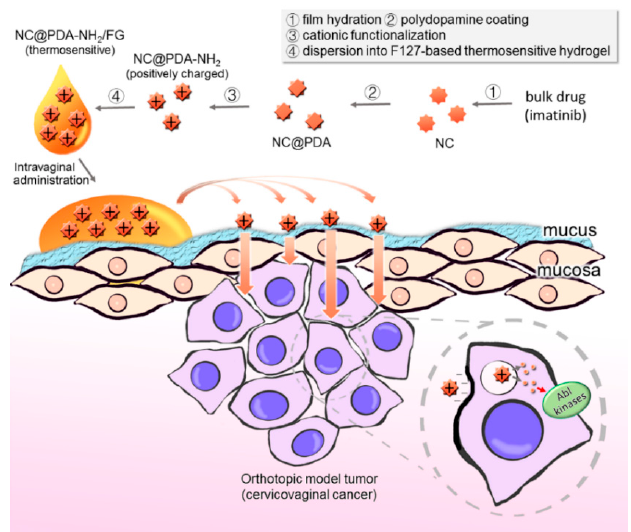
Scheme 1. Illustration of the preparation and in vivo fate of amino-group-functionalized polydopamine (PDA)-coated imatinib nanocrystals (NC) dispersed in F127 (FG) hydrogel (NC@PDA-NH 2 /FG) in the orthotopic mouse cervicovaginal cancer model after intravaginal administration.